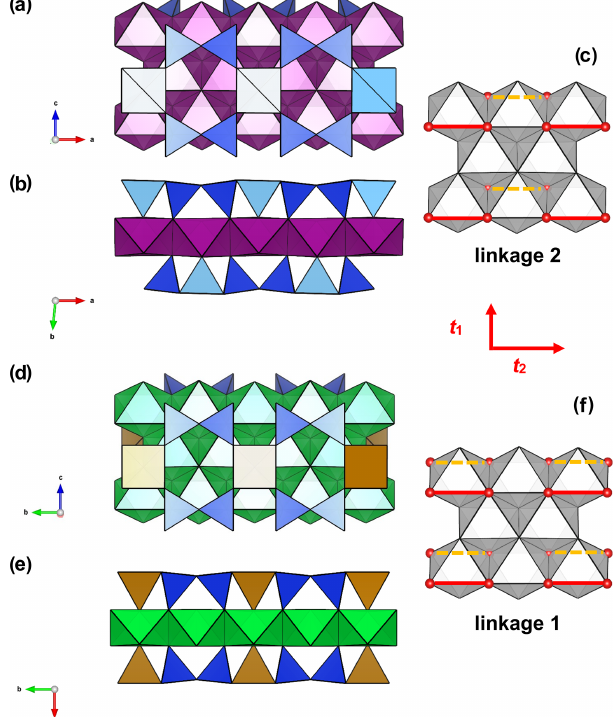
Figure 9. Linkage of H and O sheets in yoshimuraite: (a) the O (octahedral) sheet and the H (heteropolyhedral) sheet of (Si 2 O 7 ) (in blue) and M H polyhedra (in light yellow where occupied by Ti and in brown where occupied by Fe 3 + ) and (b) the TS block composed of HOH sheets; in zinkgruvanite (d) O + H sheets and (e) TS block composed of HOH sheets. M O octahedra in purple centred by Mn and in green centred by Fe 2 + . In yoshimuraite, linkage 2 occurs (c) where two Si 2 O 7 groups link to two octahedra of the O sheet ad- jacent along t 2 . In zinkgruvanite (ericssonite), linkage 1 occurs (f) where two H sheets connect to the O sheet such that two Si 2 O 7 groups on opposite sides of the O sheet link to trans edges of the same octahedron of the O